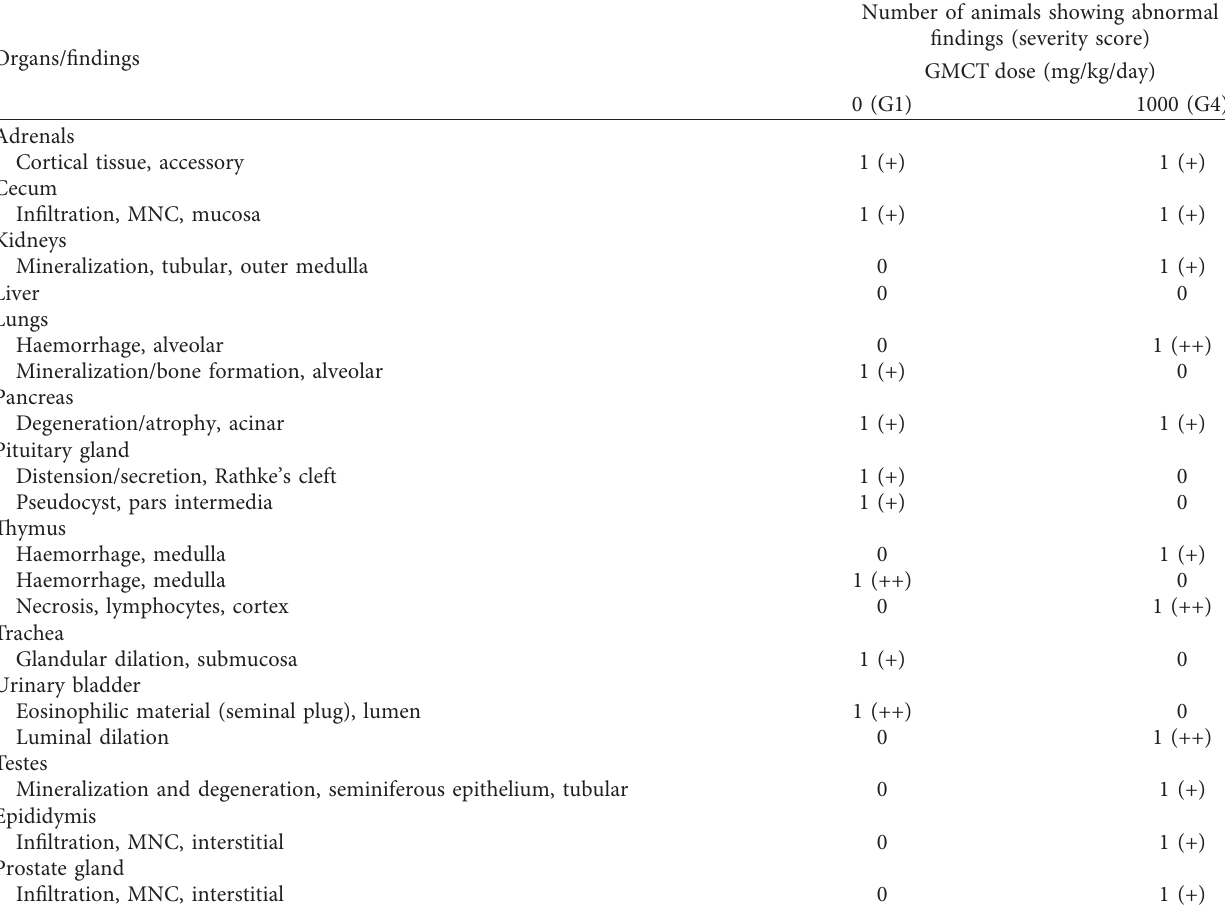
Table 11: Summary of histopathological observations on the vital organs of male Wistar rats after 28 days of oral supplementation of GMCT.